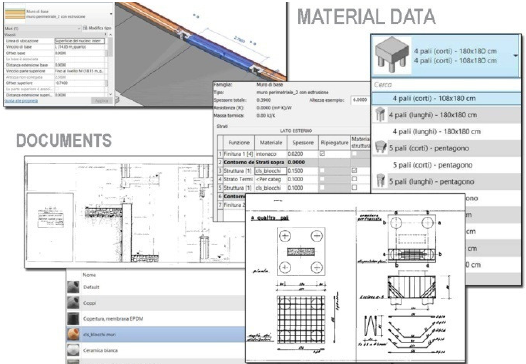
Figure 6: Work screens in a Revit environment and digitalized paper